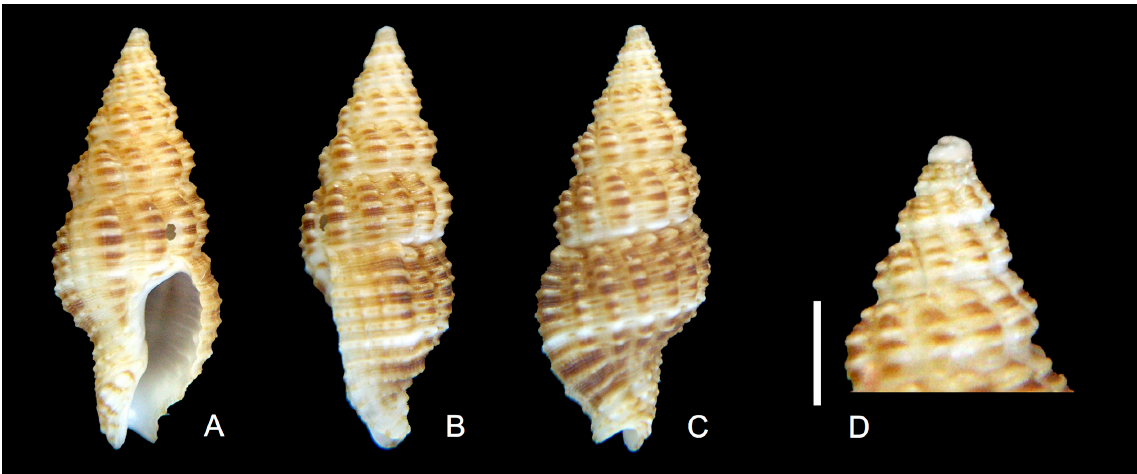
Fig. 9A–D. Sinetectula gen. nov., sp. non descr. Specimen from Indonesia, S Sulawesi, about 37 km (20 nautic miles) NW of Makassar, 4°52′62″ S, 119°07′65″ E, near a steel wreck at Tengga Tengga Reef, depth 10 m, 16.6 mm long (KF 4863). Scale bar: 2